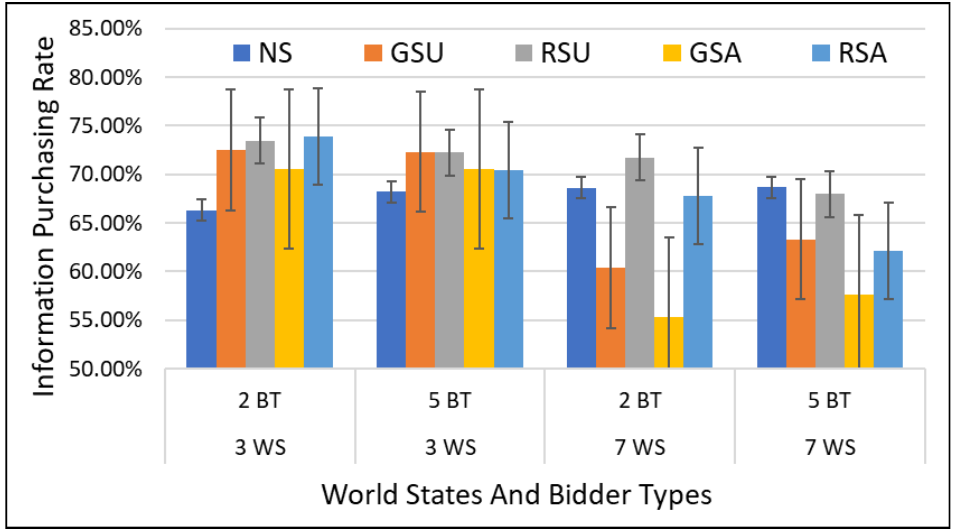
Figure 4. The information purchasing rate as a function of the number of possible world states and bidder types.